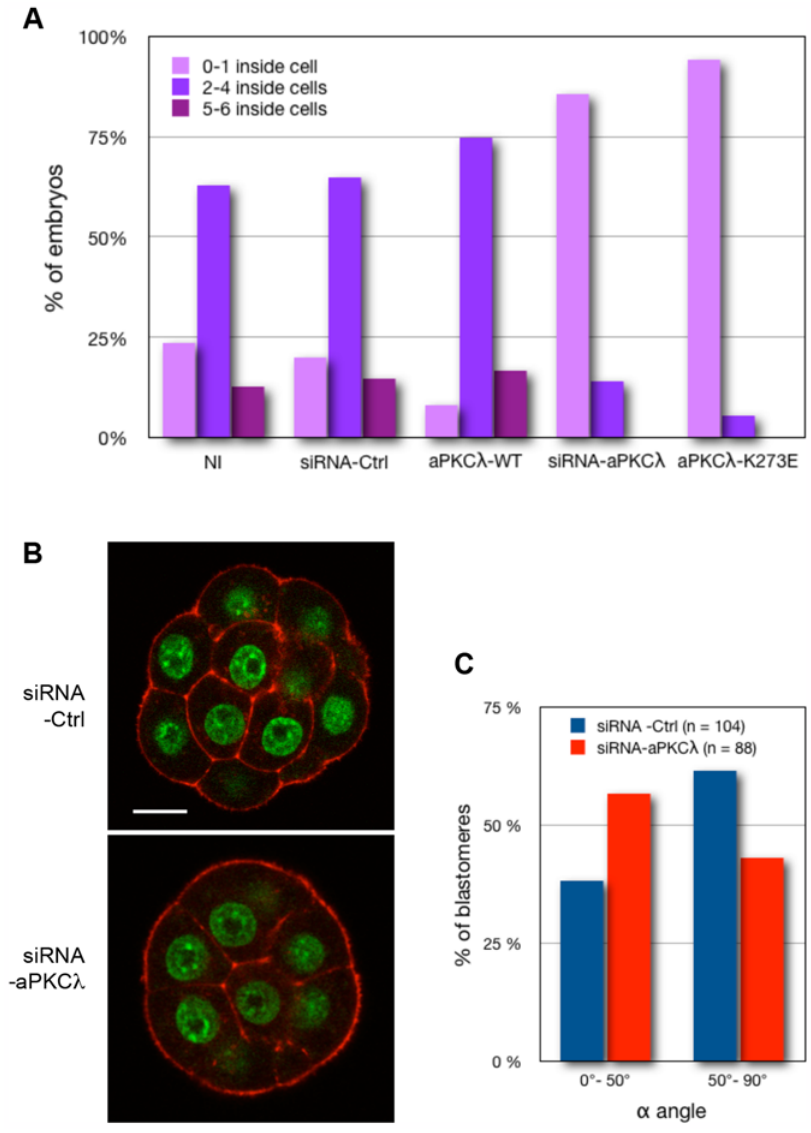
Figure 5. aPKC l -depletion leads to a strong reduction of inner cell number. (A): The number of inner cells per embryo at the 16-cell stage was determined in non-injected control embryos (NI), siRNA-aPKC l , or control siRNA (Ctrl-siRNA) injected embryos, in aPKC l -K273E or aPKC l -WT expressing embryos. siRNA or mRNA were microinjected at the 2-cell stage. (B): Embryos were recovered at the 16-cell stage and stained for actin and chromatin (red and green staining respectively). Whole embryos were scanned along the z-axis using a confocal microscope to count inner and outer cells. Cells were considered as outer or inner on the basis they had or not a contact-free membrane. Stacks of images of injected embryos are available in the supporting information section (videos S4 and S5). (C): Analysis of spindle orientation during the 8- to 16-cell stage transition. Distribution of a angle value in blastomeres from control-siRNA (blue bars) or siRNA-aPKC l (red bars) injected embryos undergoing the 8- to 16-cell stage transition. Asymmetric divisions take place when a angle is lower than 50 u . The difference between the two groups is significant (p=0,013; Fisher’s exact test). doi:10.1371/journal.pone.0007117.g005 achieved because cortical polarity is not stabilized in aPKC l - depleted blastomeres (allowing flexibility of the different cortical domains in polarized cells) and because of a stronger cortical tension. The relative tissue surface tension for both cell types would be similar, making differential adhesion less effective, as suggested by the decrease in E-cadherin staining (Fig. 3C). Thus, inner cells would tend to keep a more rounded shape and outer polarized cells would not tend to engulf inside cells, thereby leading non polarized cells to move to the periphery, where they will develop an apical pole of microvilli, due to the asymmetry in cell contacts [44].